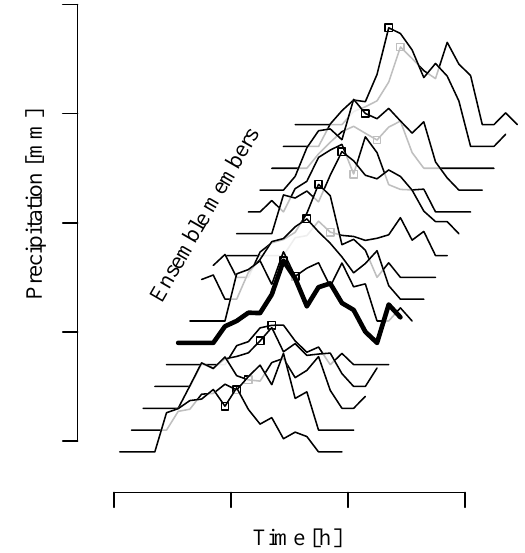
Fig. 4. Two types of evaluating the statistics of precipitation ensem- bles: hydrological event-based approach (bold line for one ensemble realisation) and data assimilation across-ensemble approach ( (cid:3) for one time